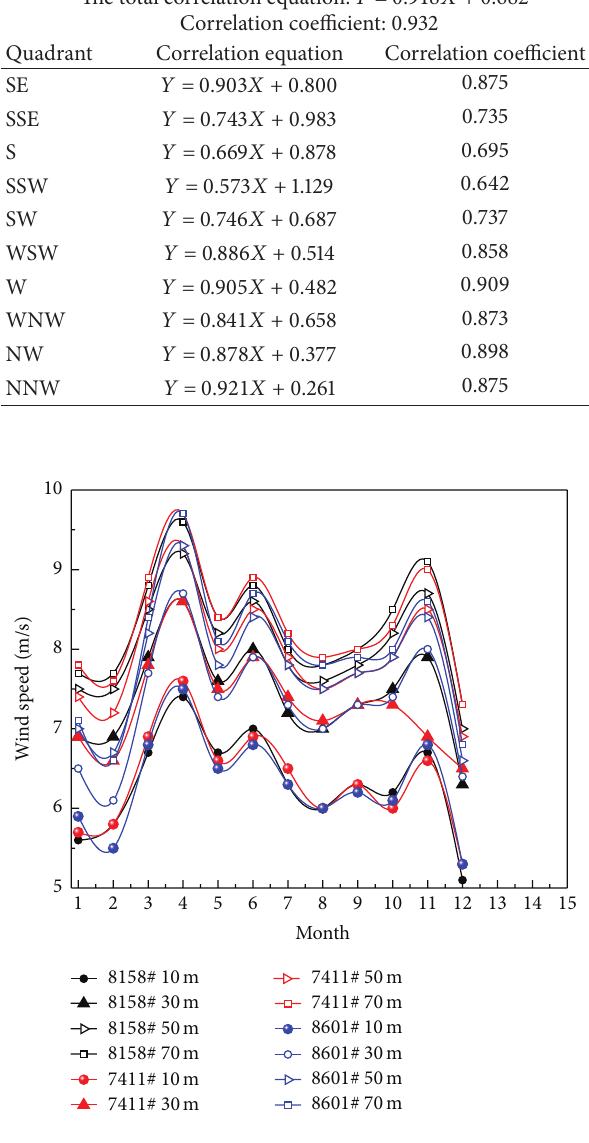
Figure 3: Wind speed of three meteorological stations at different heights in 2009